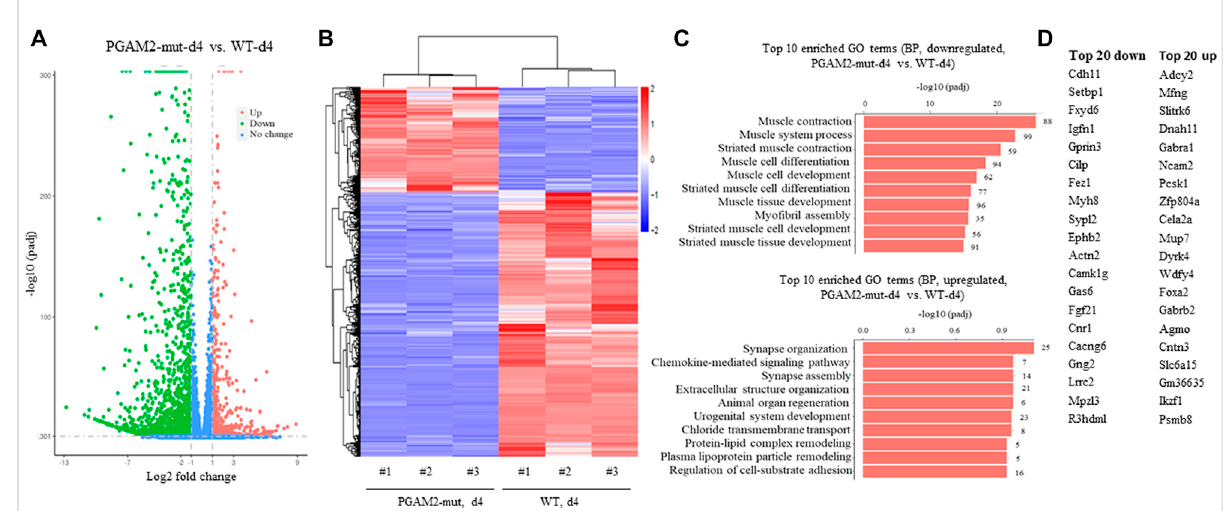
FIGURE 7 Dysregulated gene expression in PGAM2-K176R mutant C2C12 cells at differentiation day 4. Results of RNA sequencing analysis for WT and PGAM2-K176R mutant C2C12 cells at differentiation day (d)0. (A) Volcano plot with a fi lter of padj < 0.05 and a |log2 fold change| = 1 shows the changes in differentially expressed genes (DEGs) in WT and PGAM2-K176R mutant C2C12 cells. (B) Heatmap providing a global view of DEGs in WT and PGAM2-K176R mutant cells. (C) Top 10 most enriched GO terms in BPs associated with downregulated (top panel) and upregulated (bottom panel) genes in PGAM2-K176R mutant cells compared with WT cells. (D) Top 20 most downregulated (left panel) and upregulated (right panel) genes in PGAM2-K176R mutant cells compared with WT